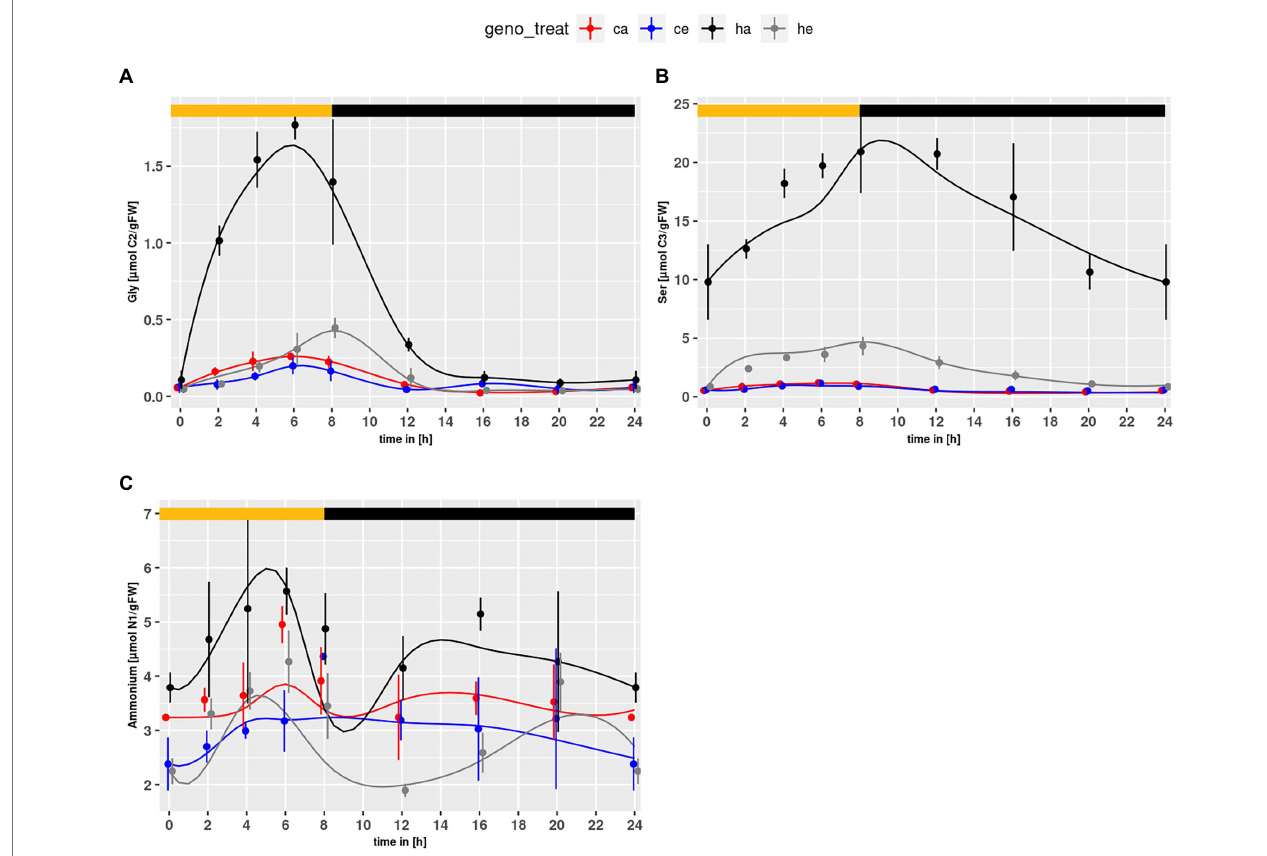
FIGURE 1 | Diurnal course of photorespiratory intermediates; (A) glycine, (B) serine, (C) ammonium. Col-0 ambient: red, Col-0 eCO 2 : blue; hpr1-1 mutant ambient: black, hpr1-1 mutant eCO 2 : grey. Shown are means with standard error ( n = 5). Lines represent the mean of 20 simulations. Light phase is indicated by yellow bar and dark phase indicated by black